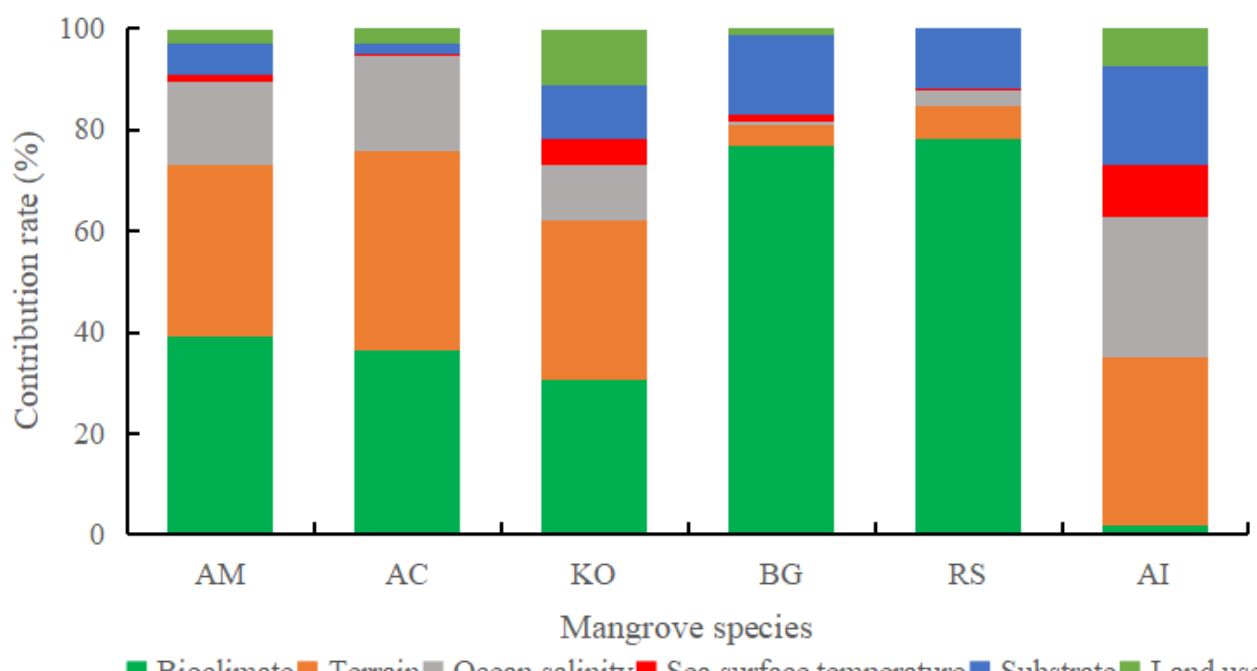
Figure 9. The contributions of the six environmental variables to predicting the mangrove species distributions ( A. marina : AM , A. corniculatum : AC , K. obovata : KO , B. gymnorrhiza : BG , R. stylosa : RS , and A. ilicifolius : AI).